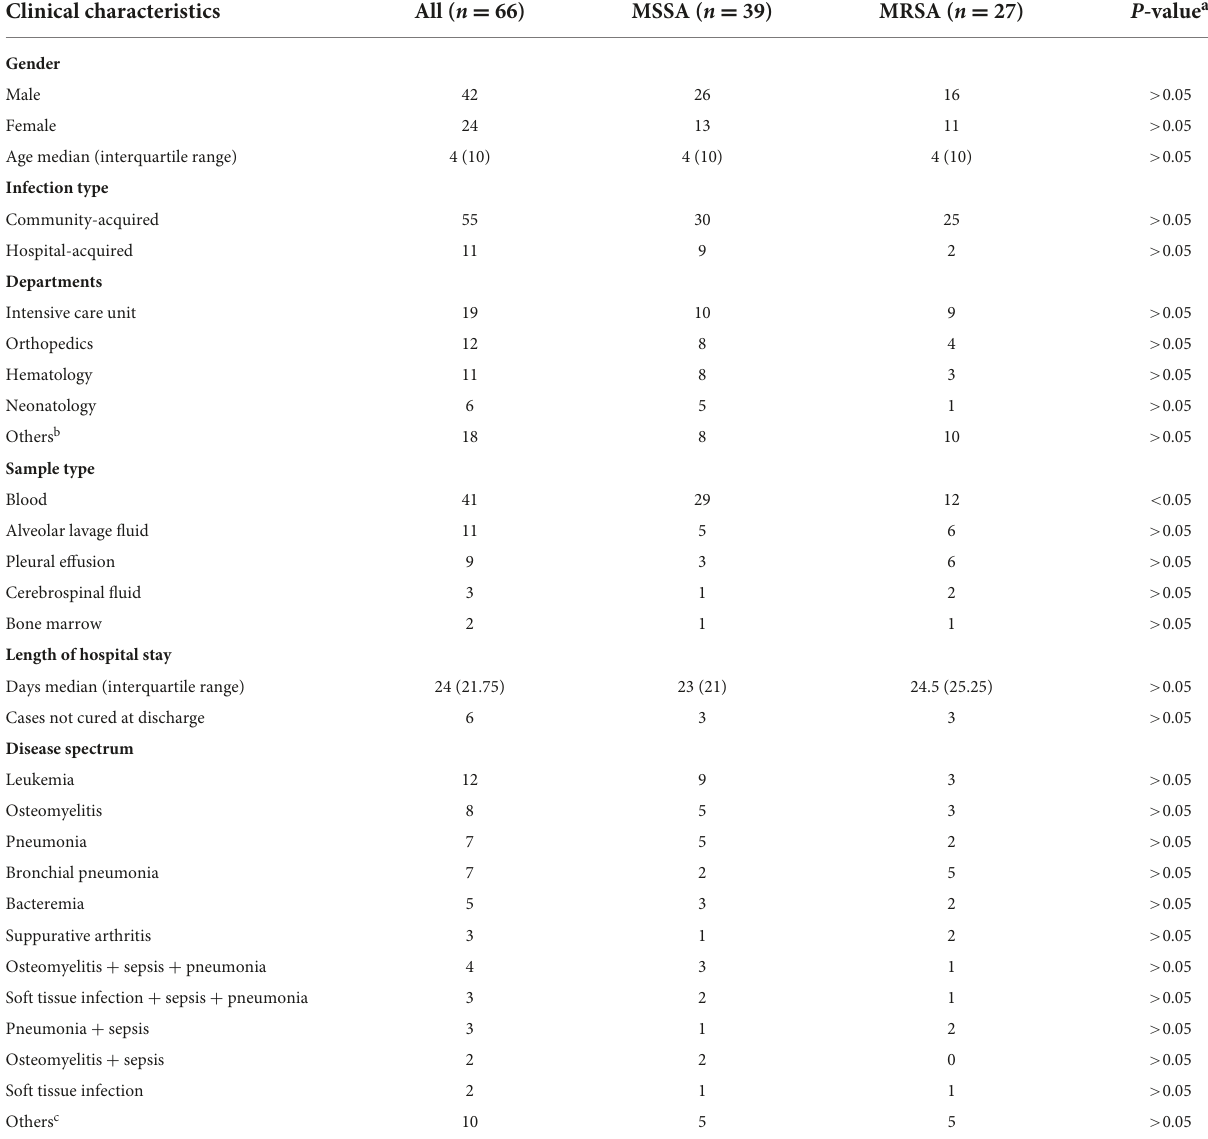
TABLE 1 Demographic and clinical characteristics of patients infected with methicillin-sensitive Staphylococcus aureus (MSSA) or methicillin-resistant Staphylococcus aureus (MRSA). Clinical